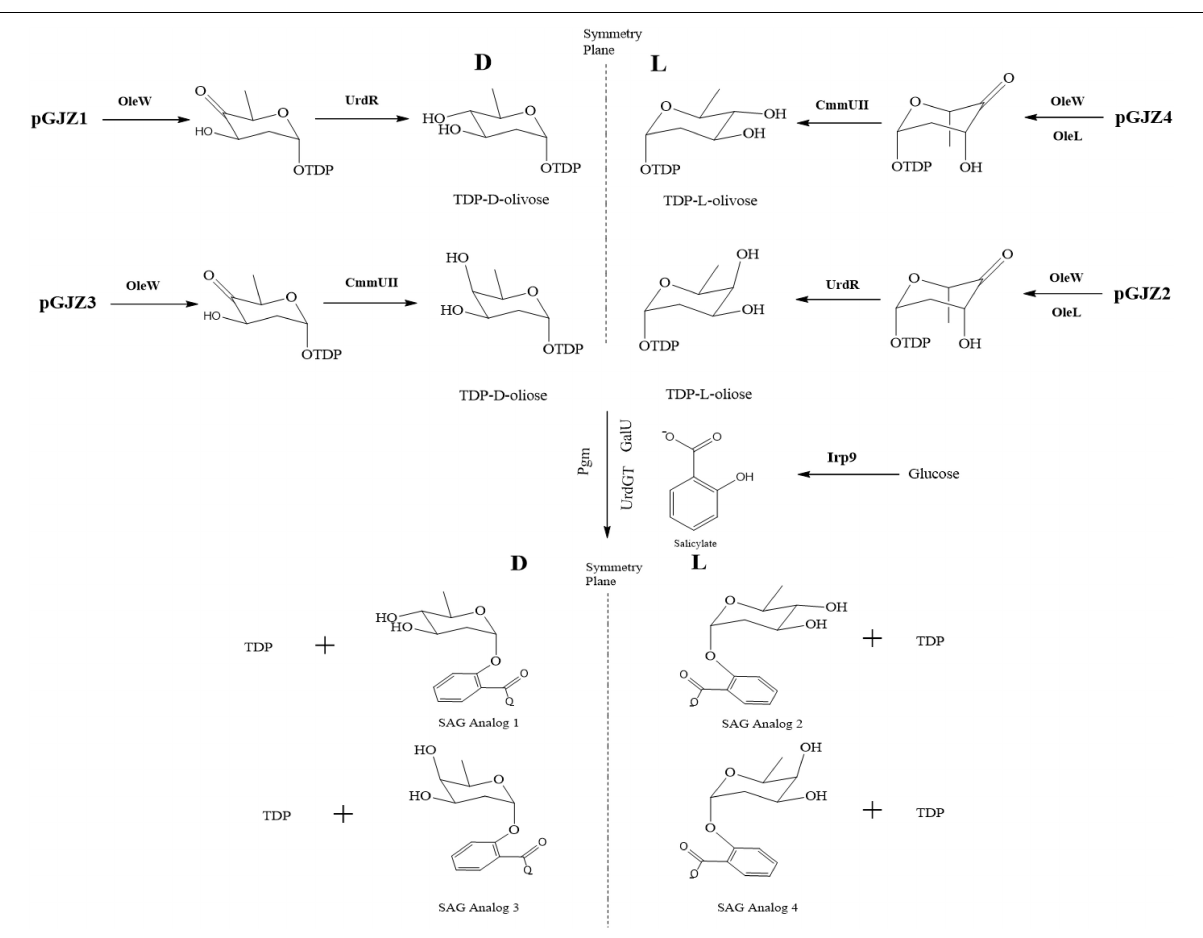
overall stability when tested for plasmid maintenance over